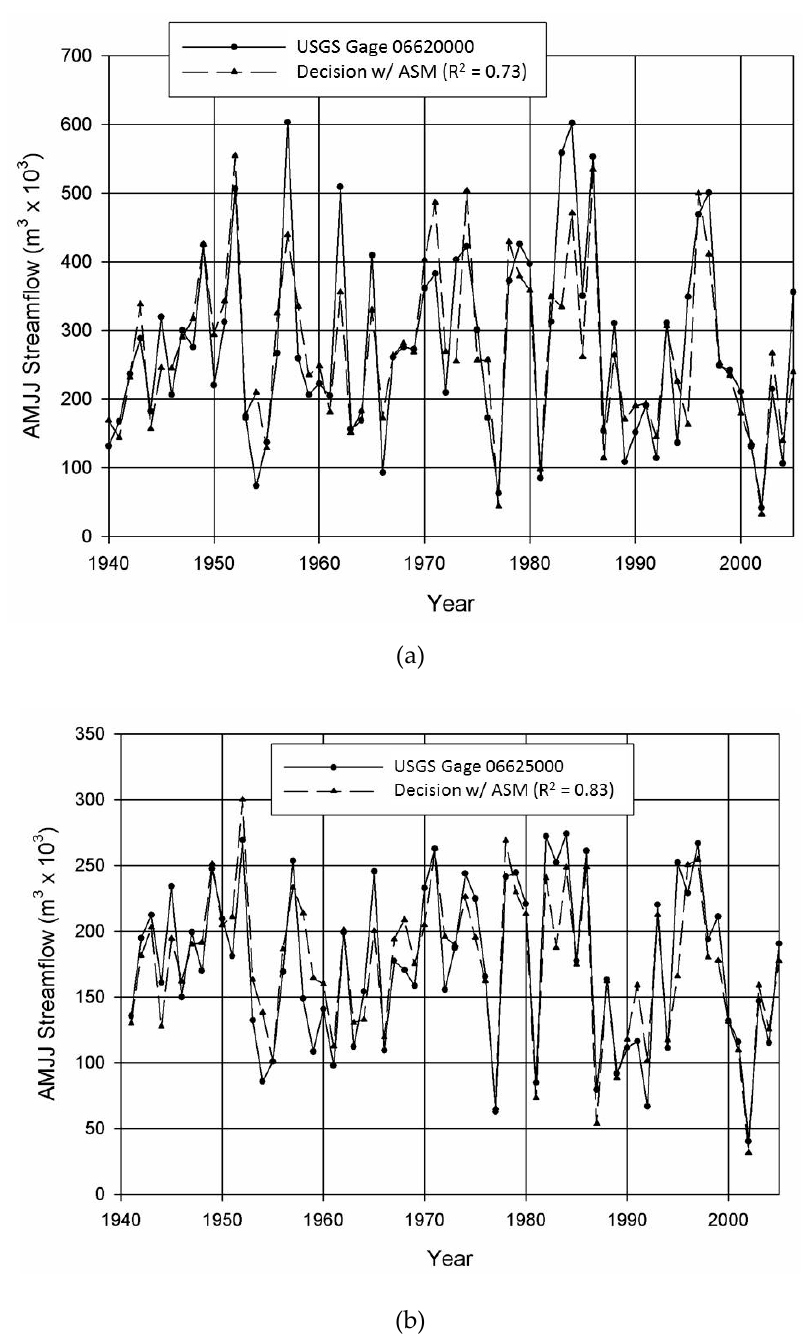
Figure 2. Plot of Gage Record and Forecast (Decision System with ASM) for ( a ) USGS 06620000 ( b ) USGS 06625000.